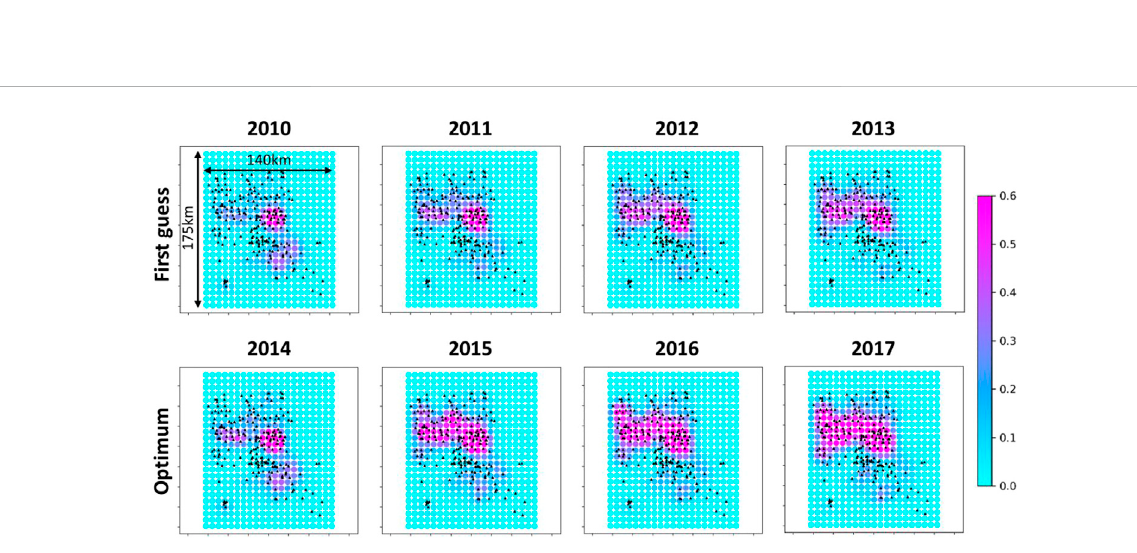
Firstguessandoptimumeventdensities(/cell)at4 kmdepthalongthebasementfaults.Theblacktrianglesindicatethelocationsoftheinjector